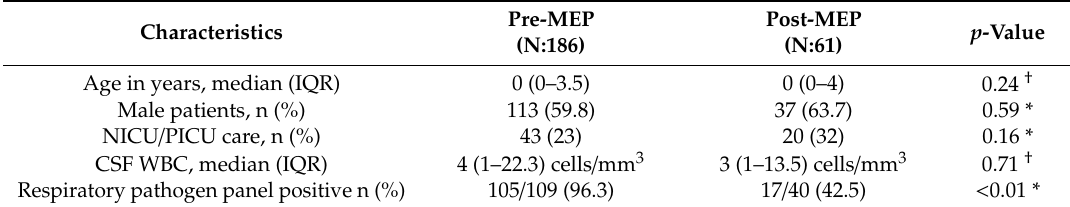
Table 1. Patient Characteristics.